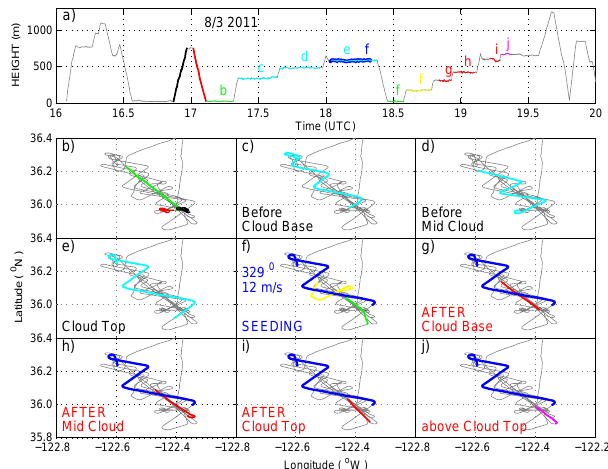
Figure 4. (a) Time series of flight altitudes and (b–j) flight paths on 3 August 2011. The flight pattern for salt seeding is shown as thick blue colors in (f–j) . The mean wind speed (12ms − 1 ) and di- rection (329 ◦ ) for the seeding period are shown in (f) . Individual legs with corresponding colors are shown in each box accordingly. duration, is summarized in Table 2.